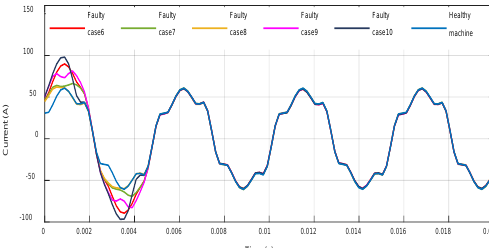
Figure 21. Current phase of the PMSM with partial demagnetization under different cases.